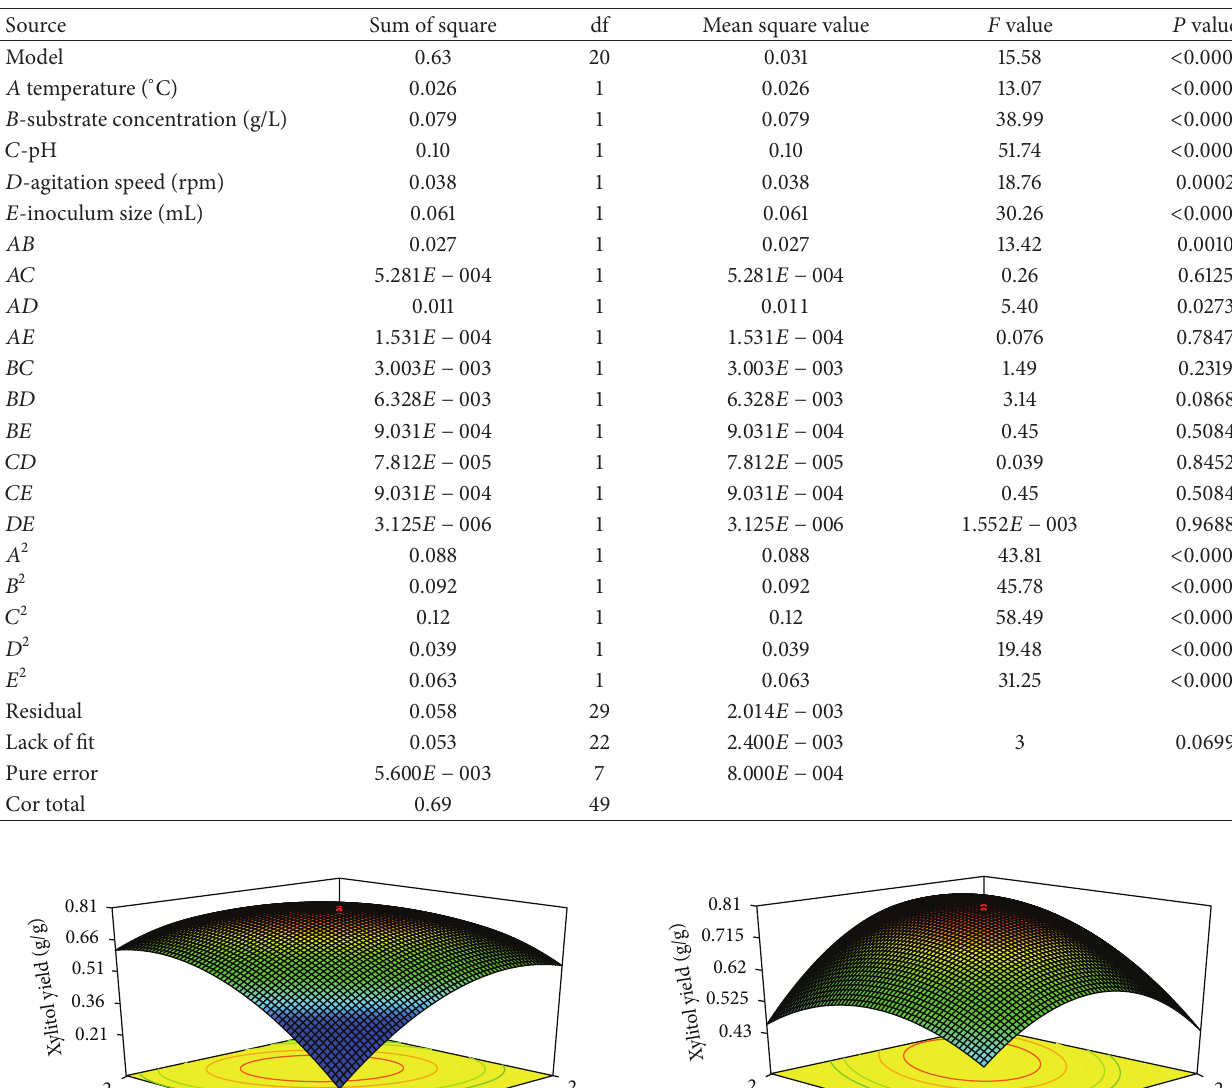
Table 7: Analyses of variance (ANOVA) for response surface quadratic model for the production of xylitol using CCD.